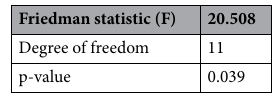
Table 6. Result of Freidman test